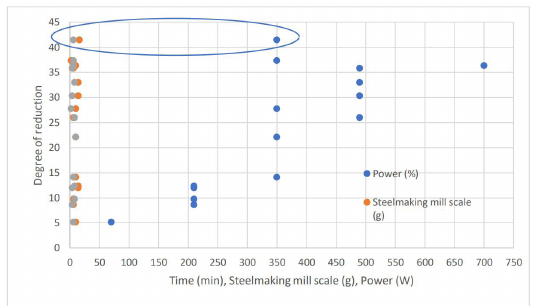
Figure 3. Degree of reduction of the mixture of coke, iron ore and steel mill scale as a function of the scale mass, power and time of contact with microwave